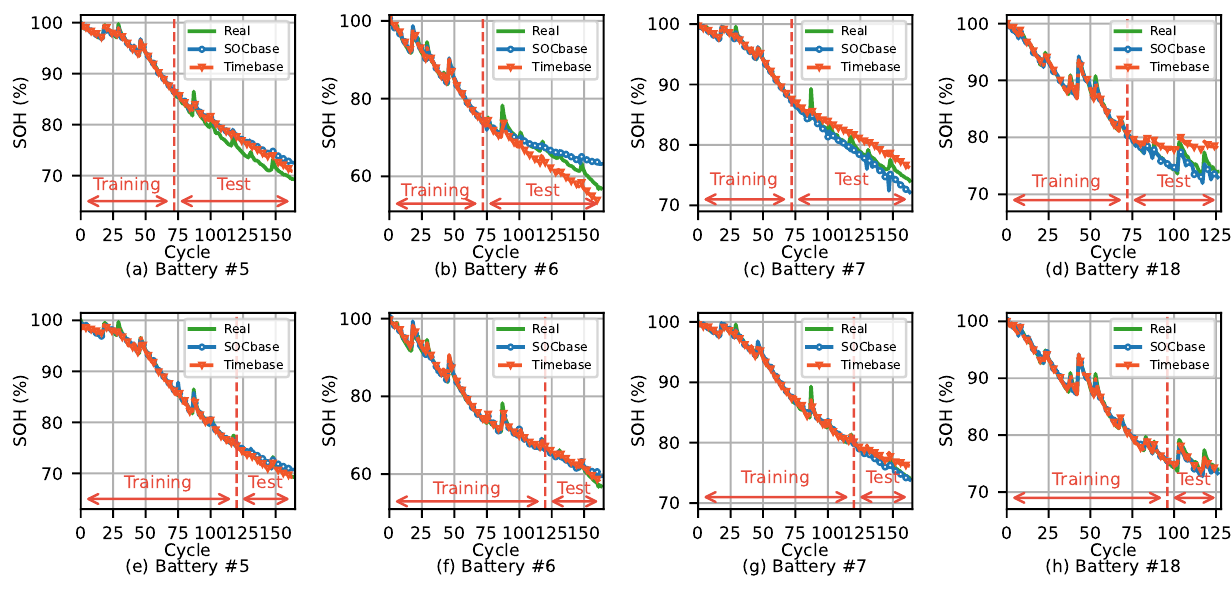
Figure 7. SOH estimation results using a CNN.